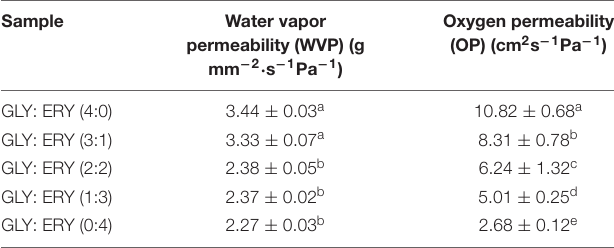
TABLE 2 | WVP and OP of the corn starch-based films supplemented with GLY and ERY (4:0, 3:1, 2:2, 1:3, 0:4). Sample Water vapor permeability (WVP) (g